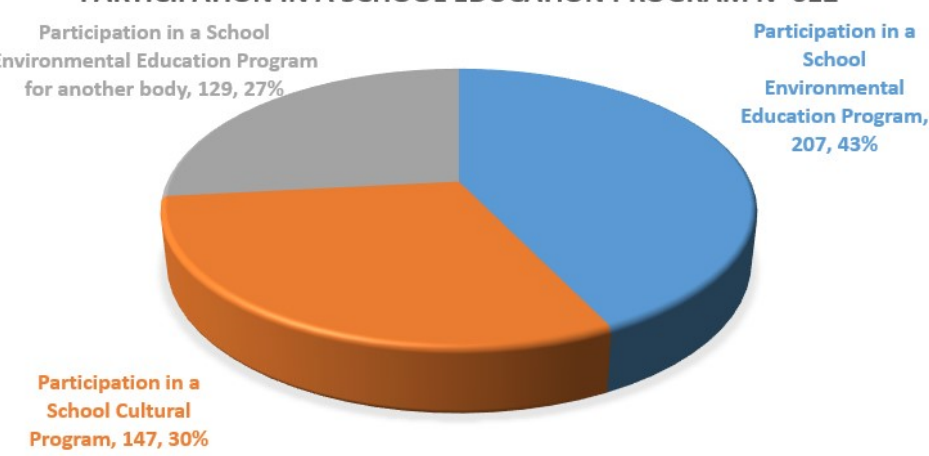
Figure 8. The results of student participation in various school educational programs, based on Georgousis et al. [81].